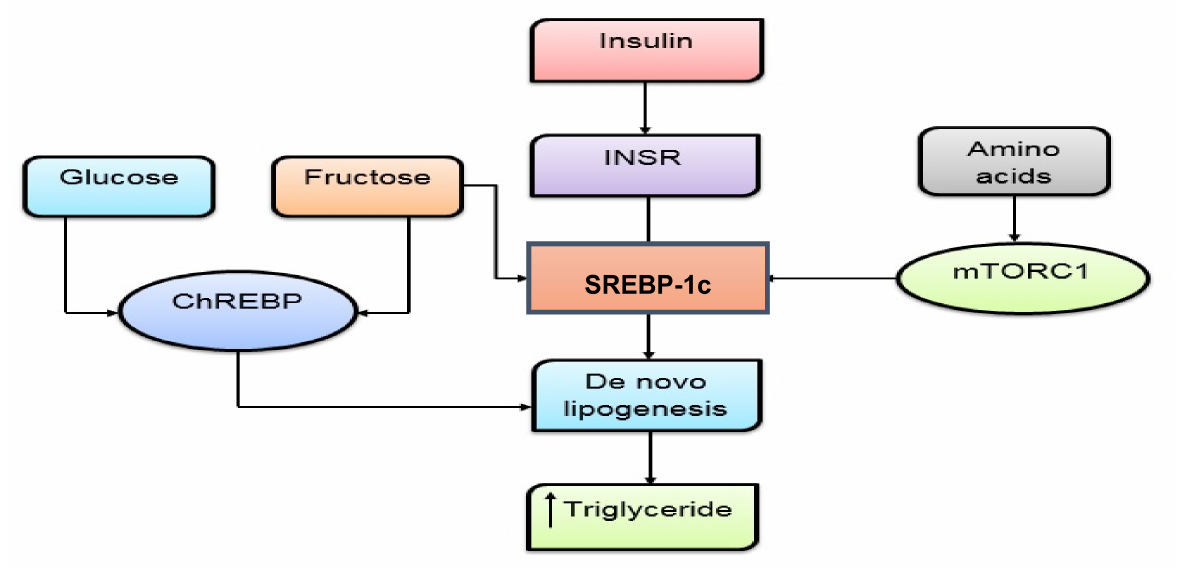
Figure 2. Relationship between liver insulin resistance and macronutrients. ChREBP—carbohydrate response element-binding protein, INSR—insulin receptor, SREBP-1c—sterol-regulated element- binding protein, mTORC1—mammalian target of rapamycin complex 1 or mechanistic target of rapamycin complex